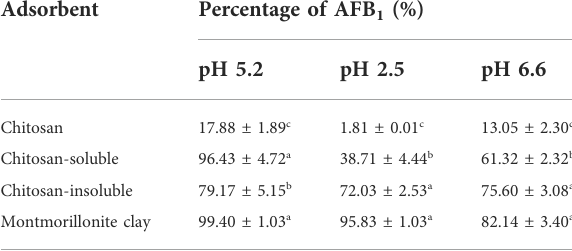
TABLE 2 Adsorption (%) of AFB 1 at different pH for chitosan, chitosan- soluble, chitosan-insoluble, and montmorillonite clay. Adsorbent